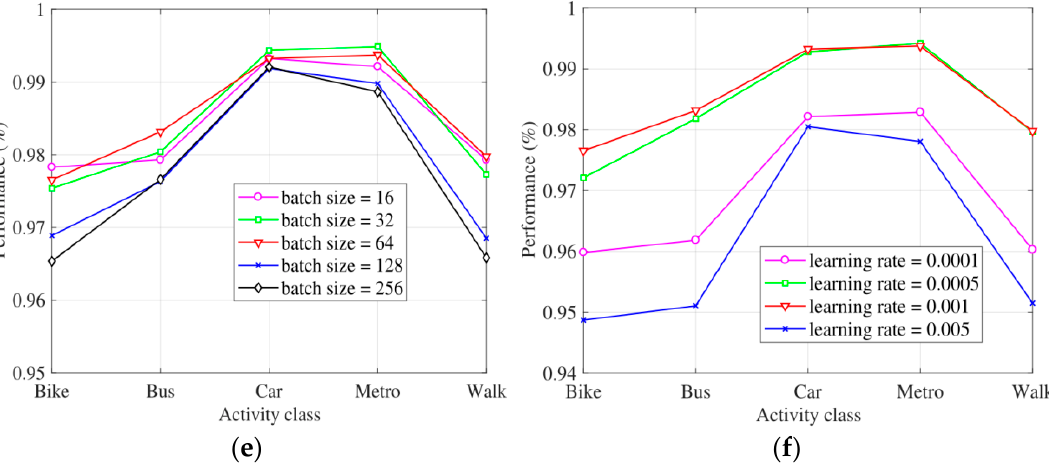
Figure 6. The performance under different hyperparameters ( a ): number of convolutional layers; ( b ): number of feature maps; ( c ): filter size; ( d ): pooling size; ( e ): batch size; and ( f ): learning rate.